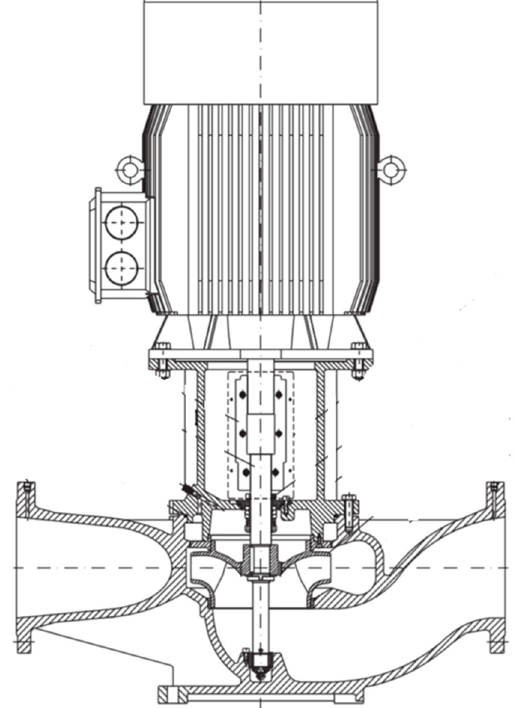
Figure 1. Illustration of the experiment pump (vertical pipe pump).